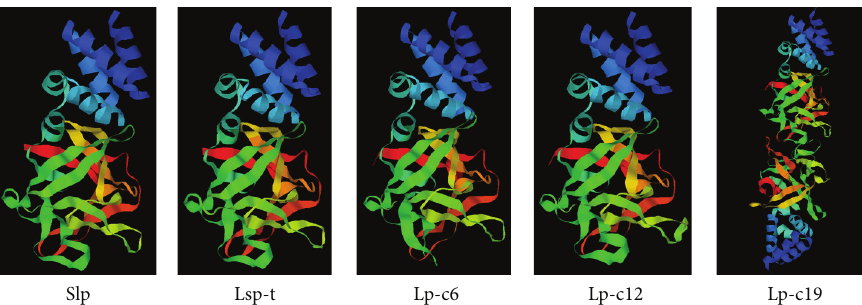
Figure 2: Predicted tertiary structures of the 30K-family proteins in the silkworm. Slp: silkworm Slp protein; Lsp-t: silkworm Lsp-t protein; Lp-c6: silkworm lipoprotein 30Kc6; Lp-c12: silkworm lipoprotein 30Kc12p; Lp-c19: silkworm lipoprotein 30Kc19G. The blue color describes the alpha helix, and the green color indicates the beta-pleated sheets.